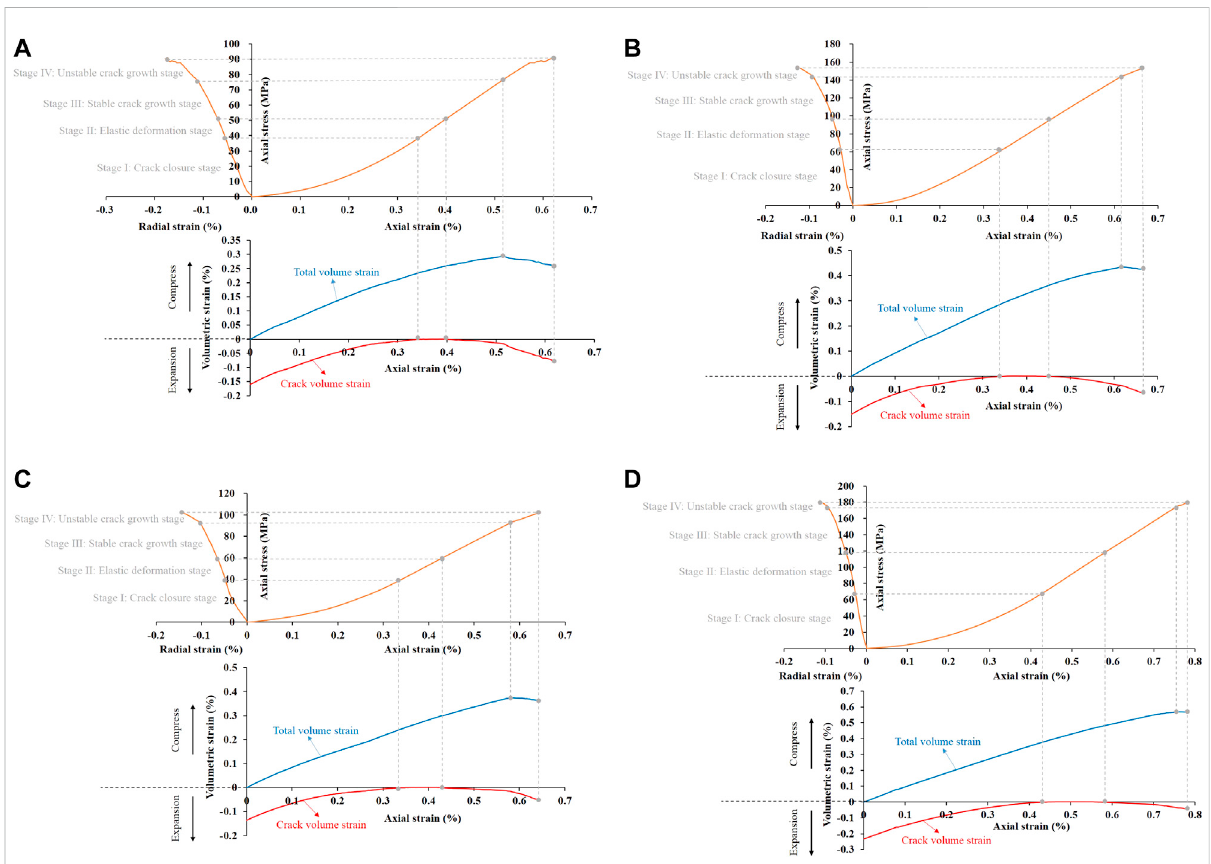
FIGURE 8 Stress-strain, total volume strain and crack volume strain curve of sample in uniaxial compression process (A) Sample with vertical interlayer after immersion (B) Sample with horizontal interlayer after immersion (C) Undisturbed sample with vertical interlayer (D) Undisturbed sample with horizontal